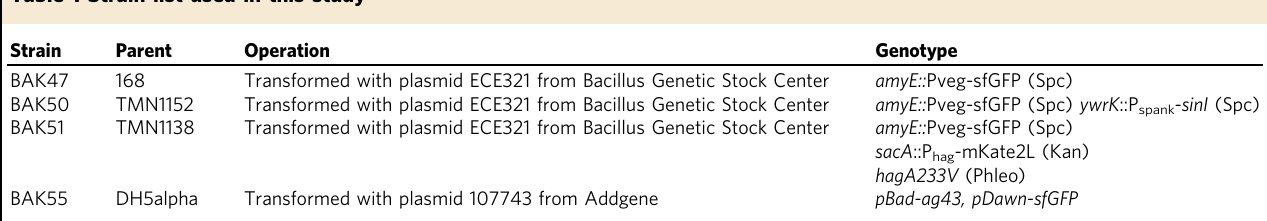
Methods Sample preparation and growth conditions . Bacterial cultures (BAK47 and BAK51) were grown in LB broth at 37°C on a shaker. An overnight culture was diluted 100× and grown for 8h. The culture was diluted 10,000×, and 50µl of culture was seeded on an LB agarose plate. These isolated bacteria on plates were grown at 21°C for 12 h and then imaged. The cover glass was not used during imaging. IPTG (isopropyl- β -D-1-thiogalactopyranoside)-inducible bacteria (BAK50) were grown in LB broth at 37 °C without IPTG induction to ensure that chaining does not occur. An overnight culture was diluted 10,000× and supple- mented with 100 μ M IPTG. A droplet of IPTG-inducible bacterial suspension was placed between two glass slides with 100-µm separation, and then imaged at